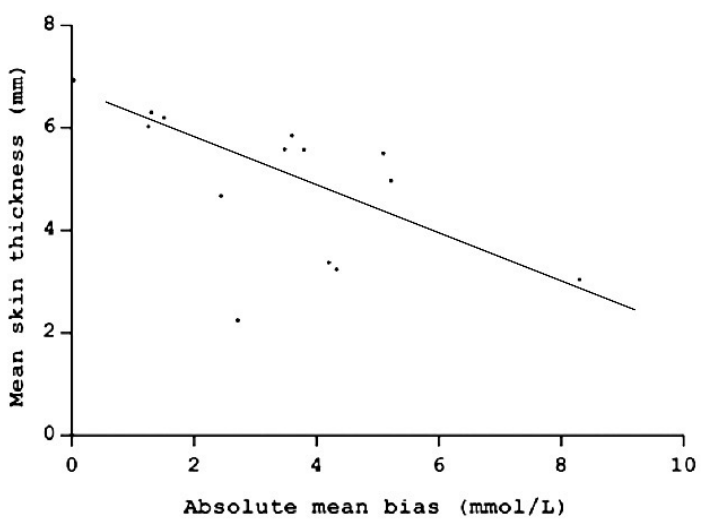
Figure 2. Correlation between skin thickness and absolute mean bias between the glucose concentrations obtained using the flash glucose monitoring system (FGMS) versus those obtained using the portable blood glucose meter (PBGM) of each dog.